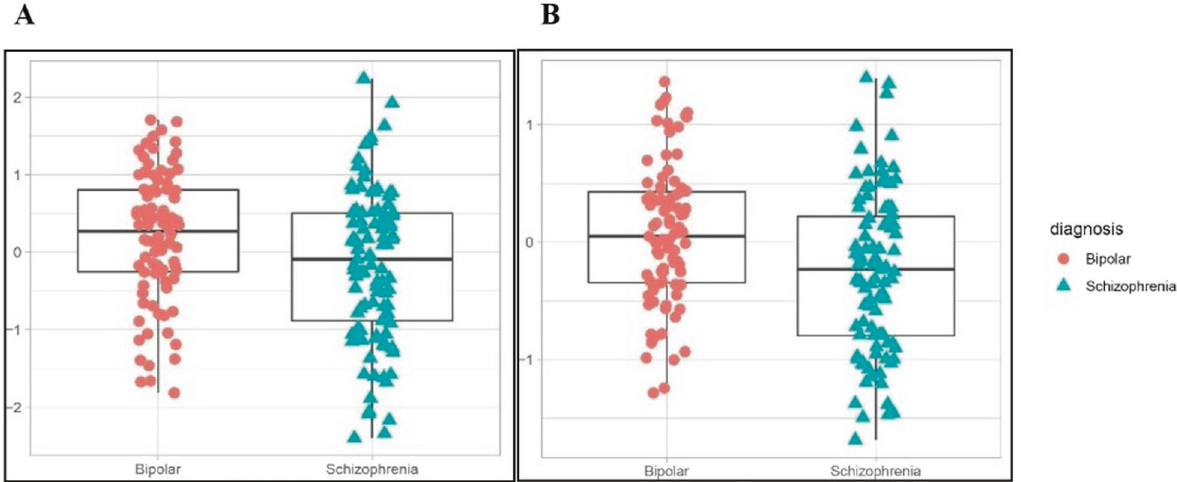
Fig. 1 Box plots and data points for two signi fi cant serum proteins differentially expressed in patients with SCZ and BD. A Complement 9 B Interleukin 1 Receptor Accessory Protein. * y-axis: age-, sex-, duration of illness-, and medication-controlled residual values of each differences in the way serum samples were obtained and handled in the group of patients (PsyCourse Study) and controls (another independent study). Therefore, our group comparisons exclusively focused on the patient groups. After applying Bonferroni adjustment, we found a signi fi cant difference between individuals with SCZ and those with BD in two serum proteins (see Supplementary Table S2 for full results): complement C9 (C9; OR = 0.38; 95% CI, 0.23-0.63; Bonferroni-adjusted p value = 0.026; Δ Nagelkerke ’ s- R 2 = 0.058) and Interleukin 1 Receptor Accessory Protein (IL1RAP; OR = 0.34; 95% CI, 0.19 – 0.60; Bonferroni-adjusted p value = 0.031; Δ Nagelkerke ’ s- R 2 = 0.050). The level of both C9 proteomic dataset in this study, and it was the only component that was signi fi cantly different between SCZ and BD (OR = 1.13; 95% CI,